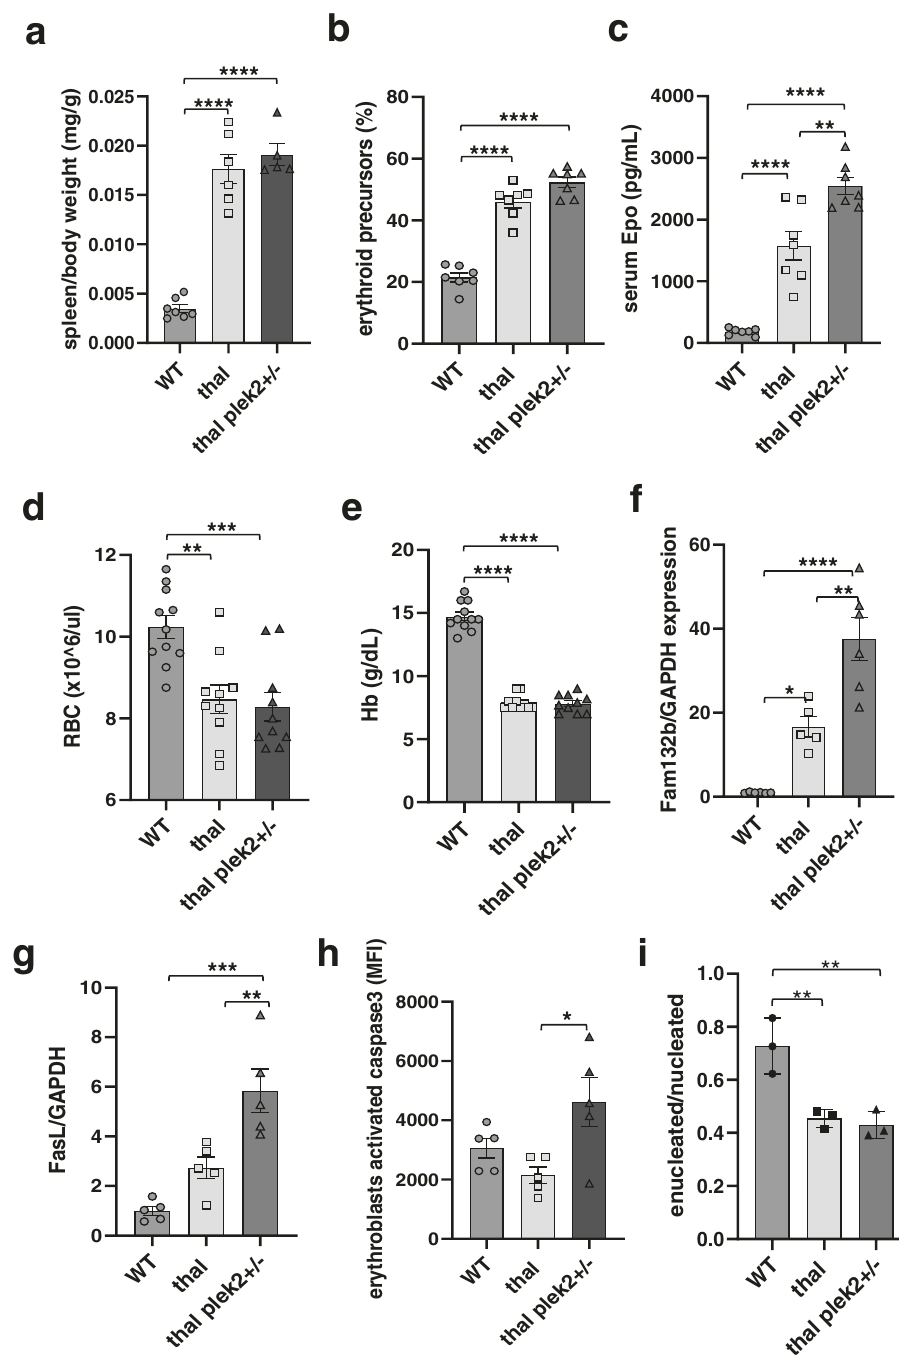
Fig. 2 Pleckstrin-2 haplo-insuf fi ciency in β -thalassemic mice results in exacerbation of ineffective erythropoiesis. a Splenomegaly observed in β - thalassemic relative to WT mice is not reversed in plek2 haplo-insuf fi cient β -thalassemic (thal plek2 + / − ) mice ( n = 5 – 7 mice/group). b Flow cytometry analysis reveals an increased fraction of bone marrow erythroblasts in β -thalassemic relative to WT mice, borderline further increased in thal plek2 + / − relative to β -thalassemic mice ( n = 4 – 5 mice/group). c Serum erythropoietin concentration reveals an increase in β -thalassemic relative to WT mice, further increased in thal plek2 + / − relative to β -thalassemic mice ( n = 4 – 5 mice/group). d Circulating RBC count and e hemoglobin were also unaltered in thal plek2 + / − relative to β -thalassemic mice ( n = 10 – 11 mice/group). f Fam132b and g FasL mRNA expression in bone marrow CD45 − erythroblasts further increased in thal plek2 + / − relative to β -thalassemic mice ( n = 5 – 6 mice/group). h Flow cytometry analysis reveals unchanged caspase 3 activation in erythroblasts from β -thalassemic mice compared to WT, but increased caspase3 activation in thal plek2 + / − relative to β -thalassemic mice despite increased serum Epo ( n = 5 mice/group). i Flow cytometry analysis reveals an expected decrease in the fraction of enucleated:nucleated bone marrow erythroblasts ( n = 3 mice/group). All data are reported as mean ± s.e.m. and p < 0.05 was considered statistically signi fi cant (one-way ANOVA) (* p ≤ 0.05, ** p ≤ 0.005, *** p ≤ 0.0005, **** p ≤ 0.00005). WT = wild type; apoTf = apo-transferrin; RBC = red blood cell; Hb = hemoglobin; Fam132b =